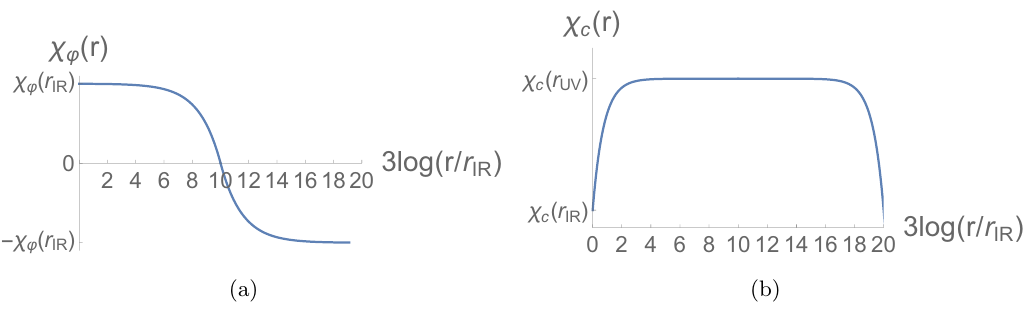
Figure 13 . The eigenmodes for ’ and c on the double throat. Here, t < 10 corresponds to the (cid:12)rst throat, t > 10 corresponds to the second, with t = 0 and t = 10 corresponding to the respective ends of the